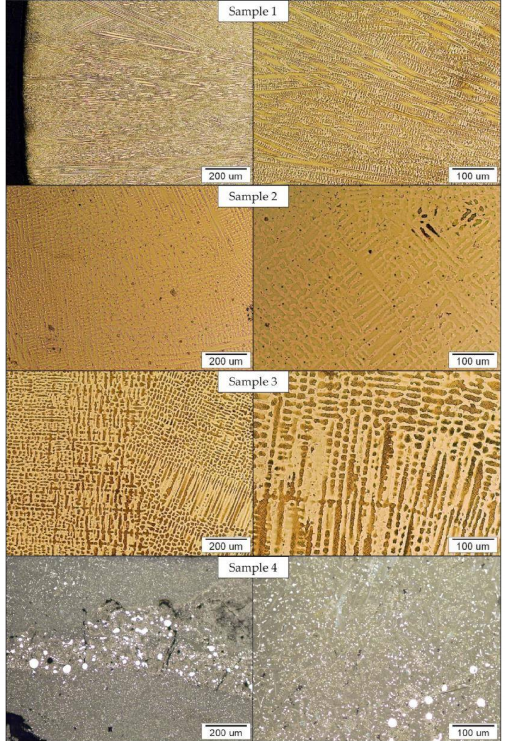
Figure 2. Optical micrographs of all samples at 100 × ( left ) and 200 × ( right ) magnifications.